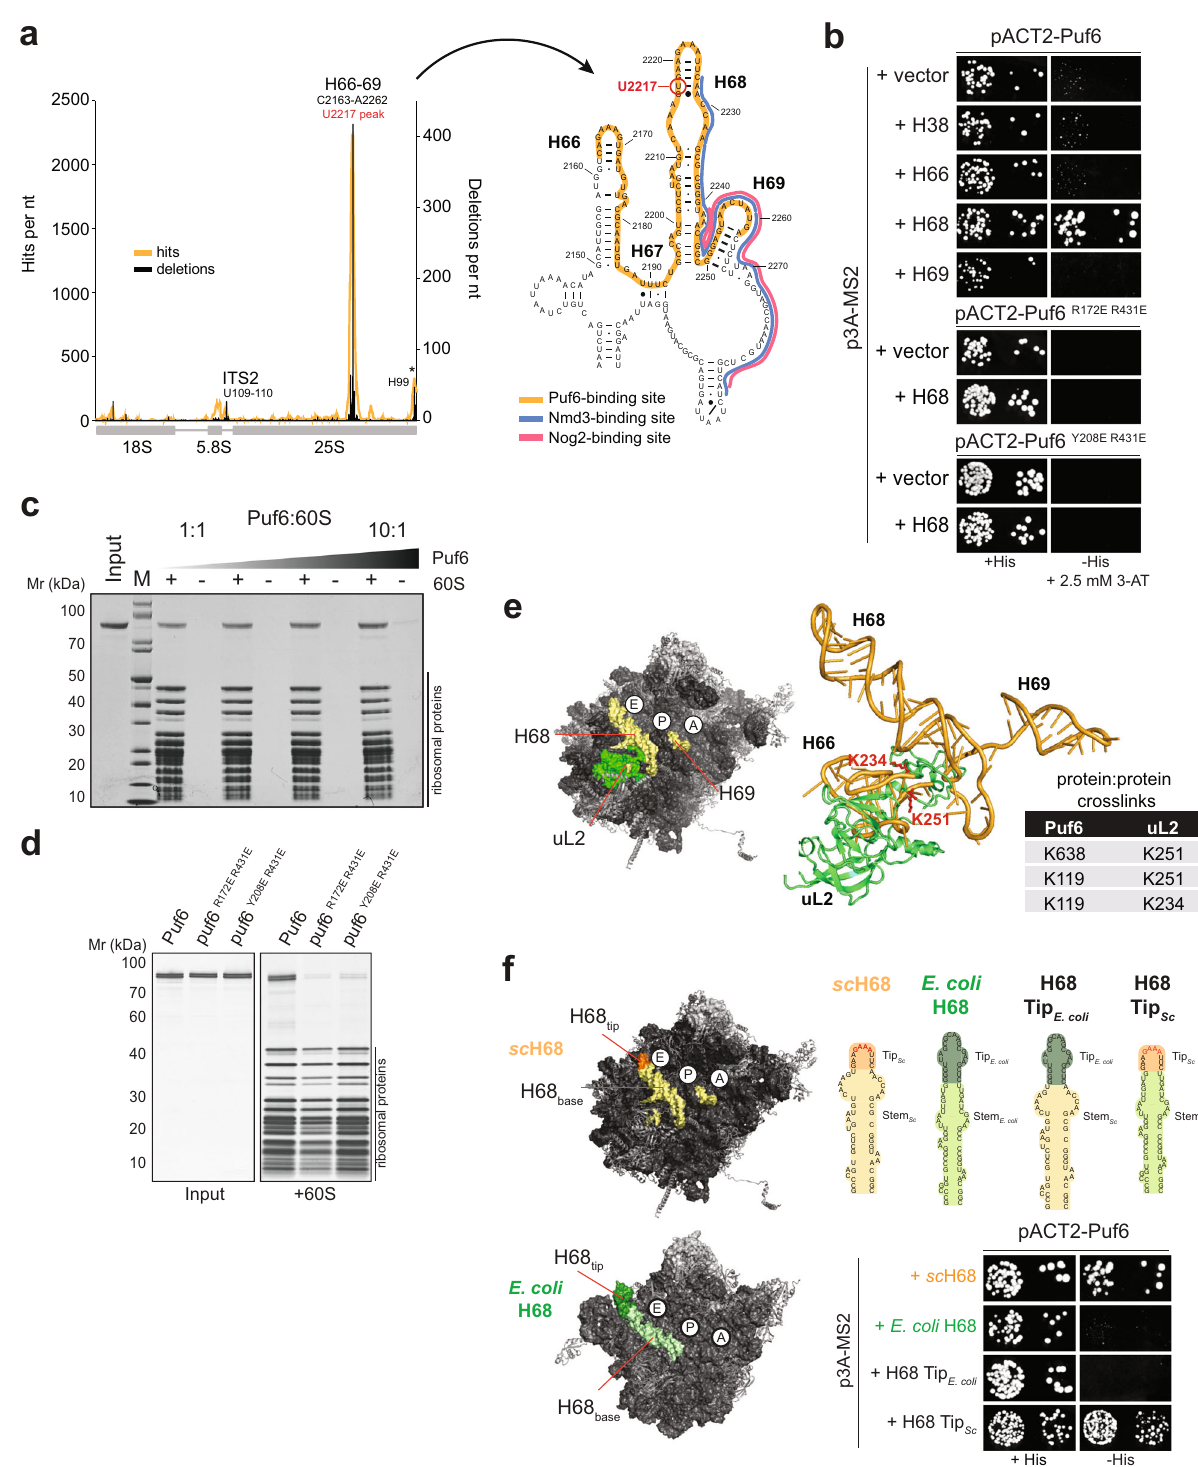
blue and red bars for TLR-TL GAAA ). Thus, Puf6 can substitute the role of Mg 2 + to promote non-canonical KL-TL GAAA as well as canonical TLR-TL GAAA tertiary contact formation (Fig. 6f) in vitro. An increase in FRET ef fi ciency was observed for the KL reporter upon Puf6-PUM addition in the presence of KL promoting buffer (Fig. 6c, right panel, red circles; d, compare blue and red bars for KL). This very likely re fl ects further compaction of KL due to Puf6-mediated TL GAAA